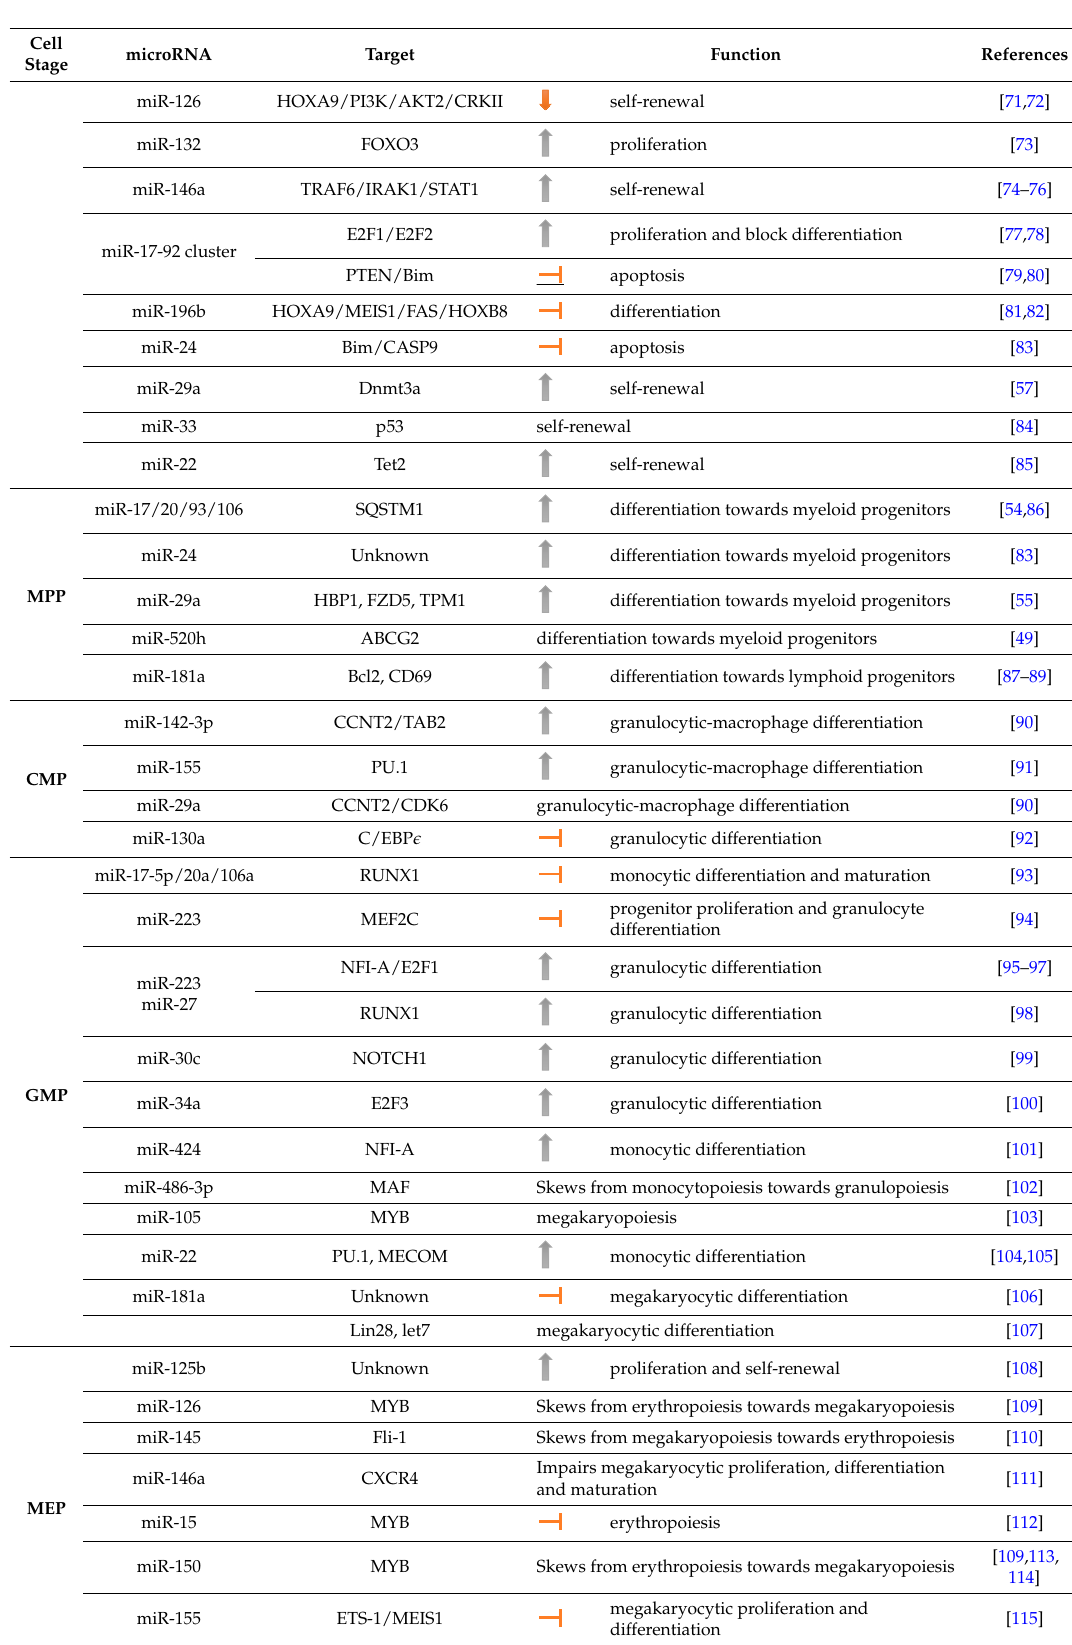
Table 1. miRNAs involved in myelopoiesis which are involved in key (stem) cell processes (differentiation, self-renewal, apoptosis and proliferation) and their identified targets.